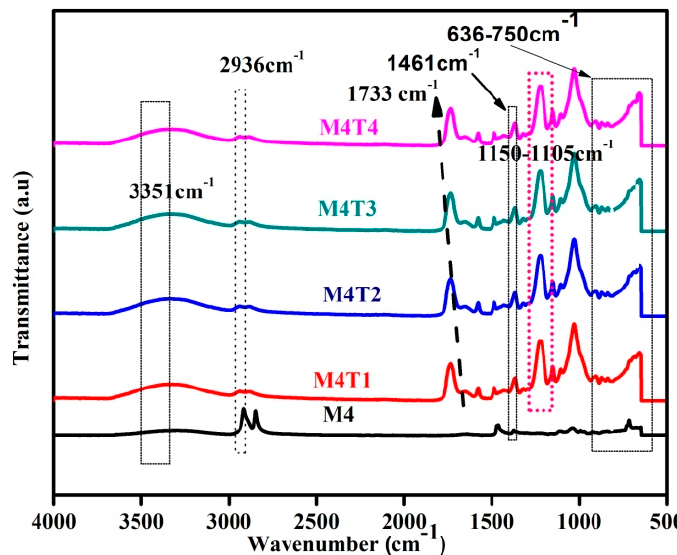
Figure 2. FTIR spectrum of the fabricated nanocomposite membranes.